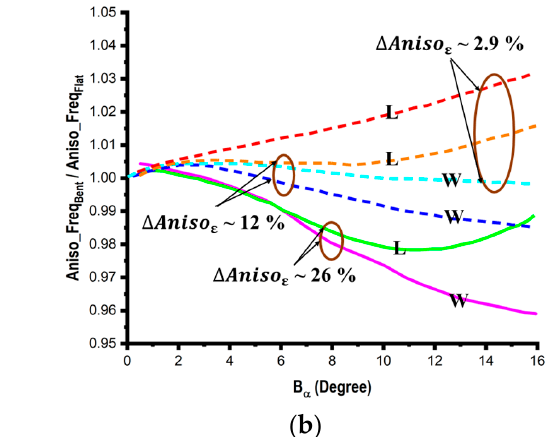
Figure 14. E ff ect of bending and anisotropy of the PDMS on its resonant characteristics.